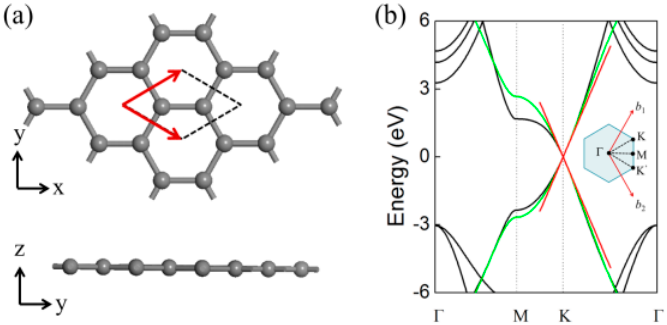
Figure 1. ( a ) Atomic structure and ( b ) energy bands of graphene. The energy bands have been calculated by first-principles (black line) and the tight-binding models: green lines indicate calculation assuming ( E 0 = 0) and red lines indicate cone-like band structure with linear dispersion near Dirac points K and K’ [35].